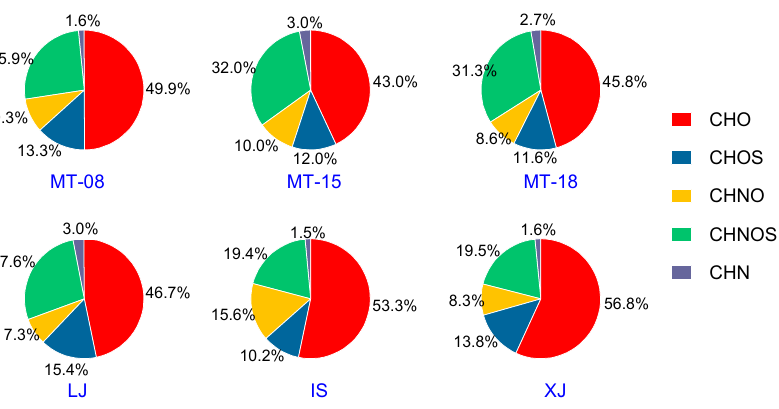
Figure 6. Pie diagrams showing the contribution of the main compound classes revealed by the combination of ESI+ and ESI − mass spectrometry analysis. Specific brands of Baijiu are indicated beneath the graphics.